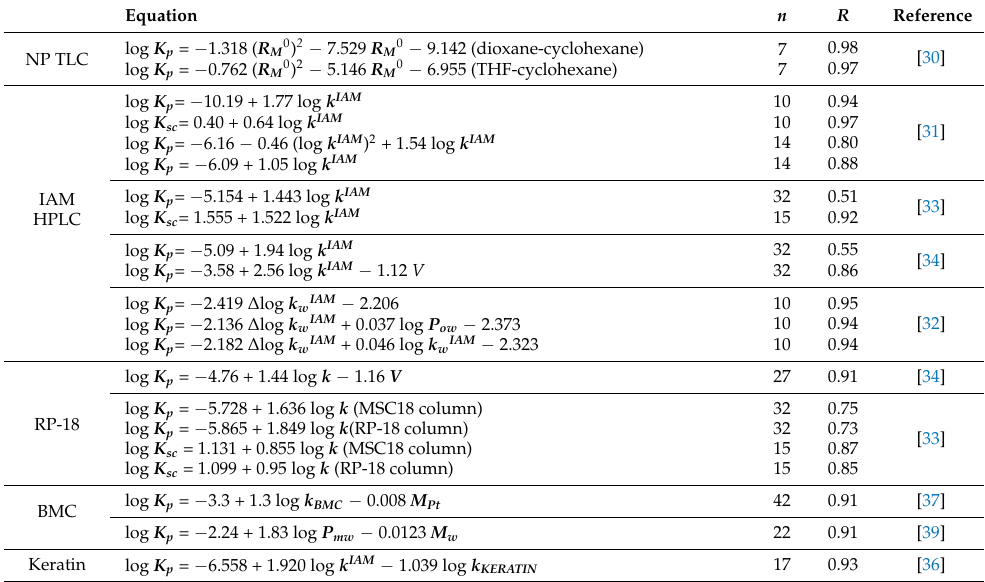
Table 2. Selected relationships between skin permeability and liquid chromatographic descriptors. Equation n R